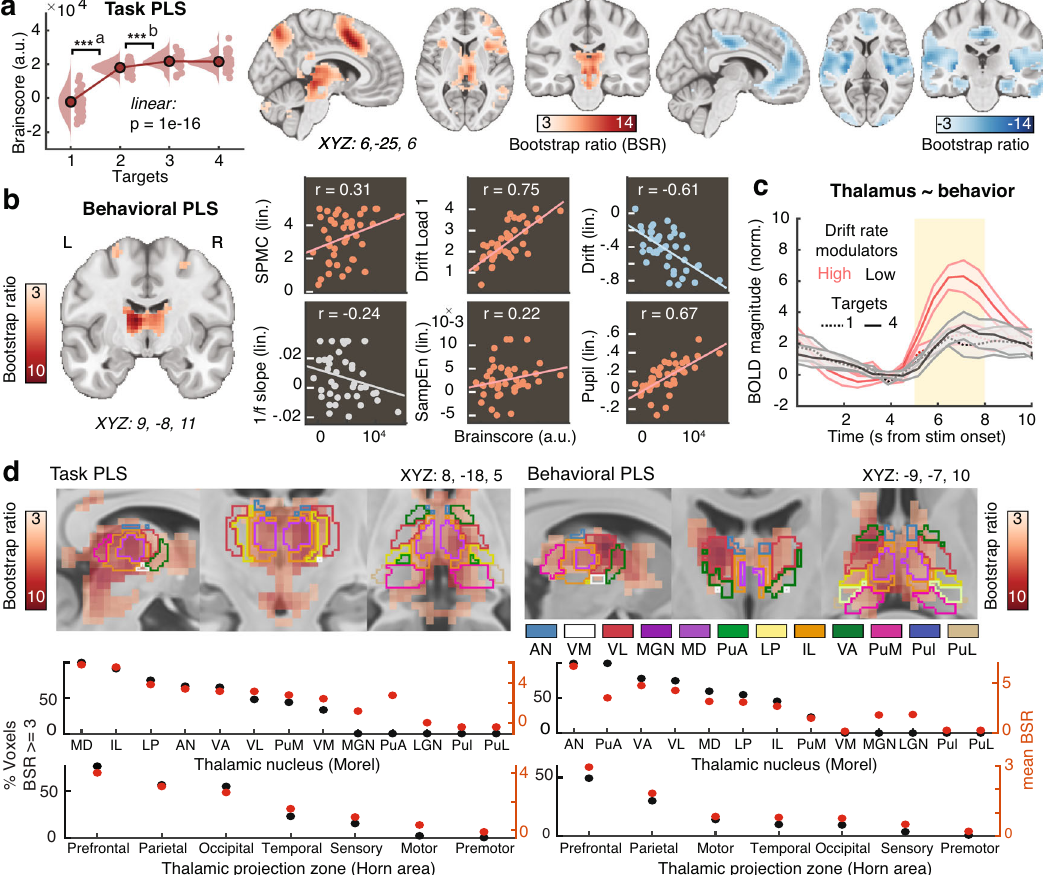
Fig. 7 Upregulation of thalamic BOLD responses during stimulus processing is related to stronger excitability increases and better performance during upcoming decisions. a Results from multivariate task partial least-squares (PLS) analysis investigating the relation of BOLD magnitude to attentional uncertainty. Data are within-subject centered for visualization (see “ Methods ” ; n = 42 participants; ***a: p = 1.9e − 18, ***b: p = 8.7e − 5, linear: b = 7491.1, 95% CI = [6372.2, 8609.99], t (41) = 13.52). Panel a indicates p values from two-tailed paired t -tests; pairwise comparisons were Benjamini-Hochberg- adjusted for multiple comparisons. Activity maps show positive (left) and negative (right) bootstrap ratios of LV1, thresholded at a bootstrap ratio of 3 ( p ~0.001). Supplementary Fig. 5a/b presents the full loading matrices for LV1 and LV2. b Results from behavioral PLS, probing the association between linear changes in BOLD magnitude with behavioral, electrophysiological, and pupillary changes under uncertainty ( n = 42 participants). Supplementary Fig. 5c presents the LV ’ s complete loadings. SPMC = spectral power modulation component. c Visualization of thalamic modulation with uncertainty, split between low- ( n = 21) and high- ( n = 21) behavioral drift modulators (mean ± SEM). The yellow shading indicates the approximate stimulus presentation period after accounting for the delay in the hemodynamic response function. Supplementary Fig. 5d plots all target conditions by group. d Thalamic expression pattern of the fi rst task LV and the behavioral LV. Scatters below indicate the major nuclei and projection zones in which behavioral relations are maximally reliable. See “ Methods ” for abbreviations. Strongest expression is observed in antero-medial nuclei that project to fronto-parietal cortical targets. Source data are provided as a Source Data fi